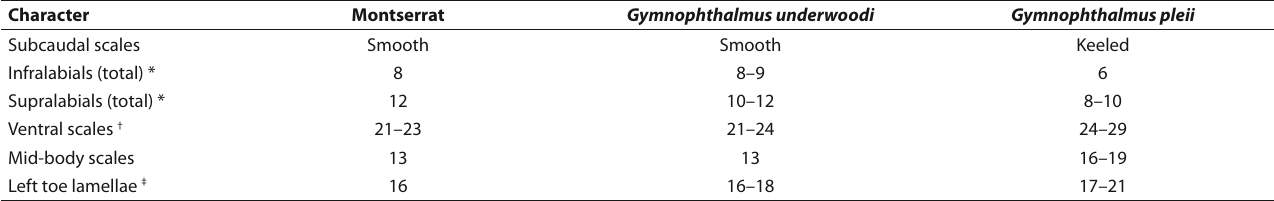
Table 2. Scale counts of the two Montserrat specimens and known Antillean species of Gymnophthalmus published in C ole et al. (1990), h oogmoed et al. (1992), and t homAs